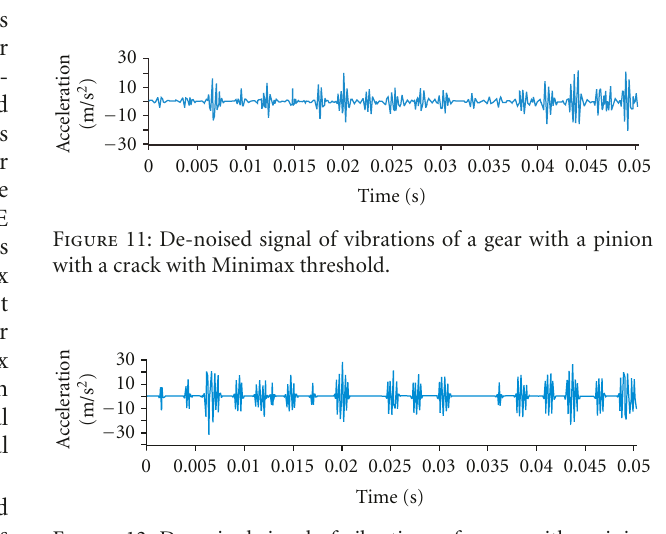
Figure 12: De-noised signal of vibrations of a gear with a pinion with a crack with Universal